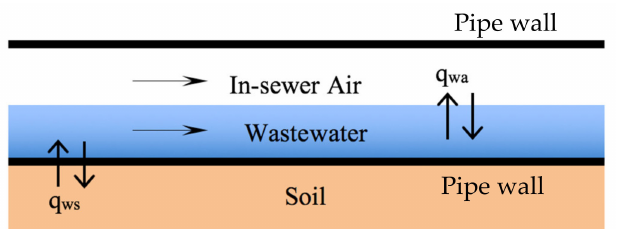
Figure 6. Illustration of heat transfer processes in a sewer pipe. q is the heat transfer rate (Watt) between wastewater (w) and in-sewer air (a) and soil